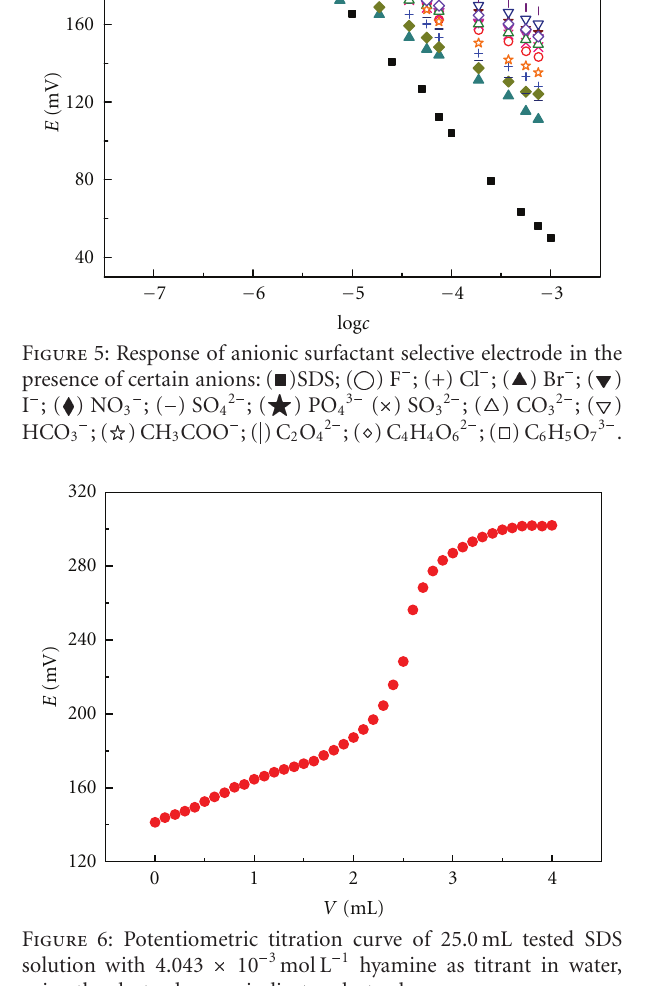
Figure 6: Potentiometric titration curve of 25.0mL tested SDS solution with 4.043 10 (cid:2) 3 molL (cid:2) 1 hyamine as titrant in water, (cid:3) using the electrode as an indicator electrode.